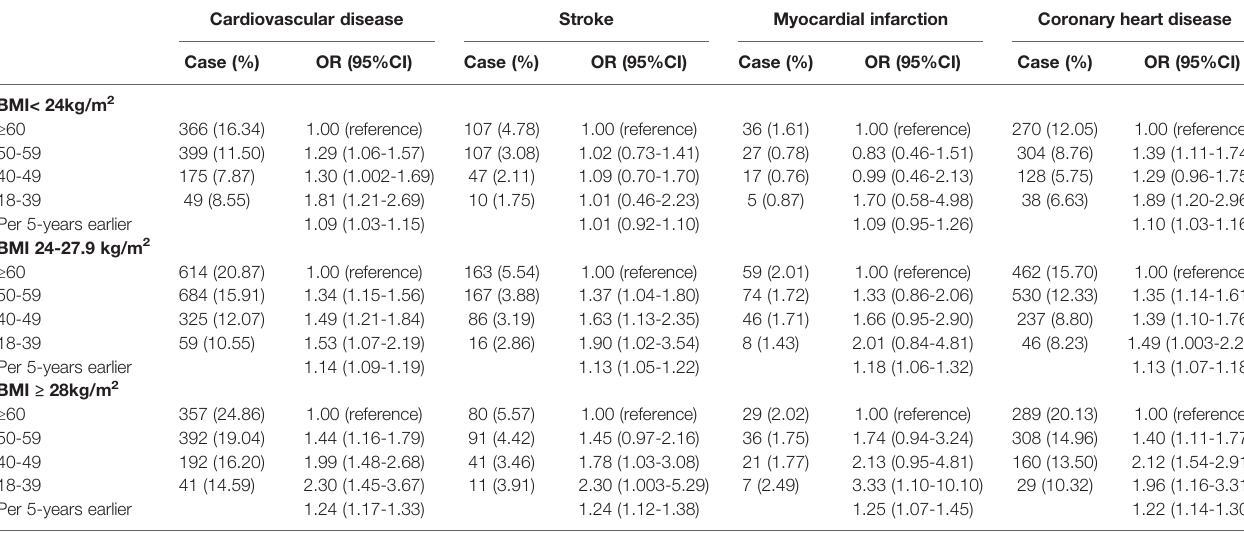
TABLE 3 | Association between age at diagnosis of diabetes and cardiovascular disease risk by BMI categories. Cardiovascular disease Stroke Myocardial infarction Coronary heart